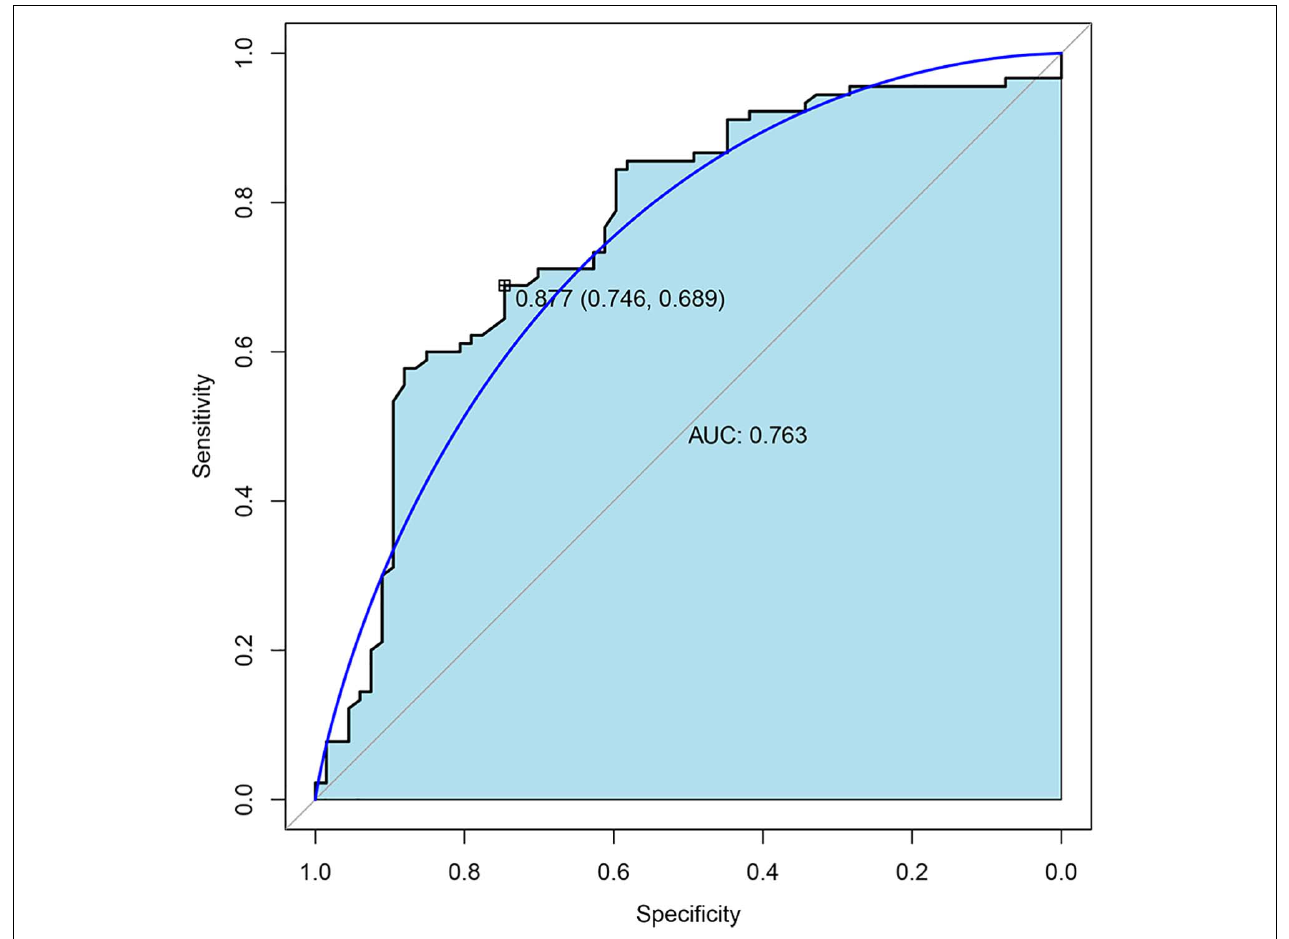
FIGURE 4 | Receiver operating characteristic (ROC) curves and area under the curve (AUC) of the combination of four gene biomarkers for 3-year mortality prediction of OSC patients in GEO